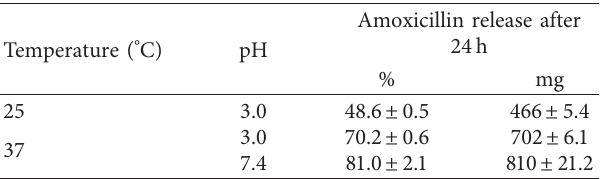
Figure 12: Cumulative release of amoxicillin from composite hydrogel PAAm/starch 50/50 in PCA, pH 3.0, and PBS, pH 7.4 at 37 ° C. The error bars represent the standard deviation ( n � 3). Table 1: Quantification of amoxicillin release from composite hydrogel of PAAm/starch 50/50 at different temperatures and pH